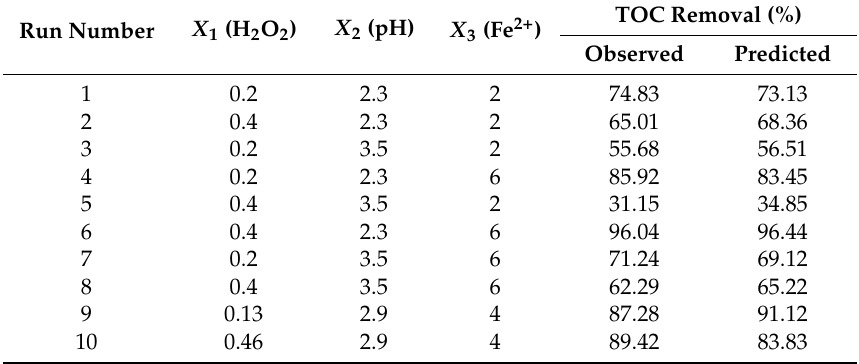
Table 2. Experimental designs of the five levels and their experimental results and predictive